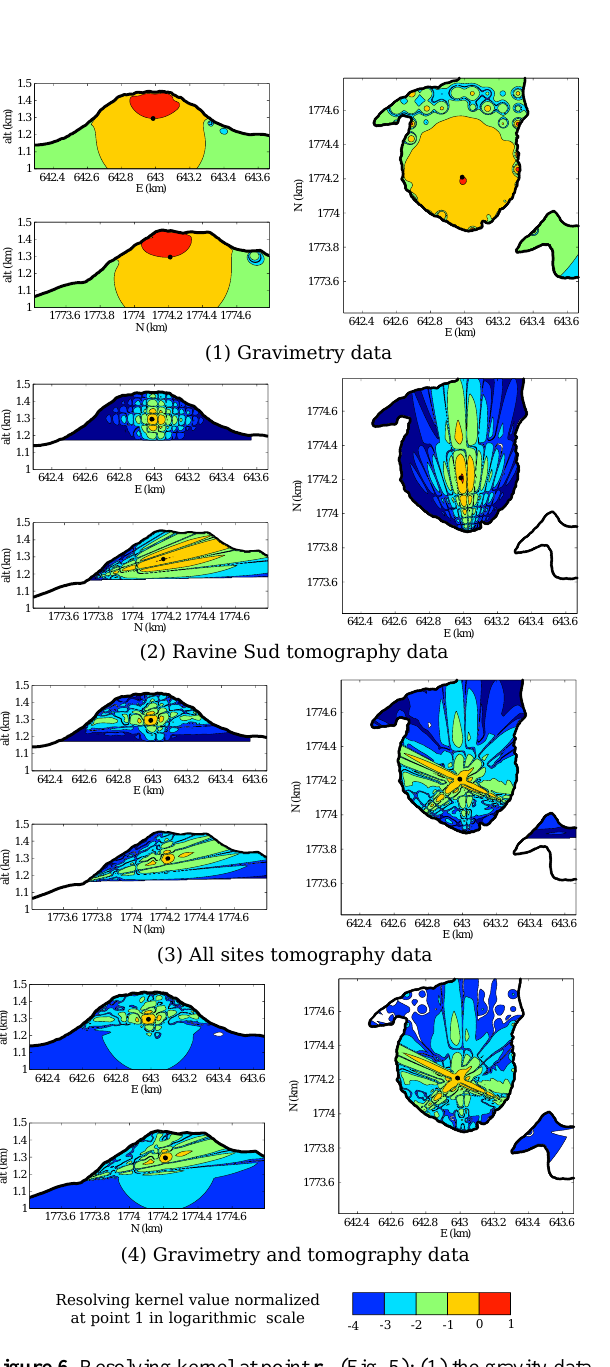
Figure 6. Resolving kernel at point r 1 (Fig. 5): (1) the gravity data alone; (2) Ravine Sud muon radiography alone; (3) combination of three muon radiographies; and (4) joined muon and gravity data sets. See Fig. 1 for the locations of gravity measurements and the three sites for muon radiographies. The resolving kernel’s absolute value is normalized with reference to the value computed at point r 1 and represented with a log 10 scale.